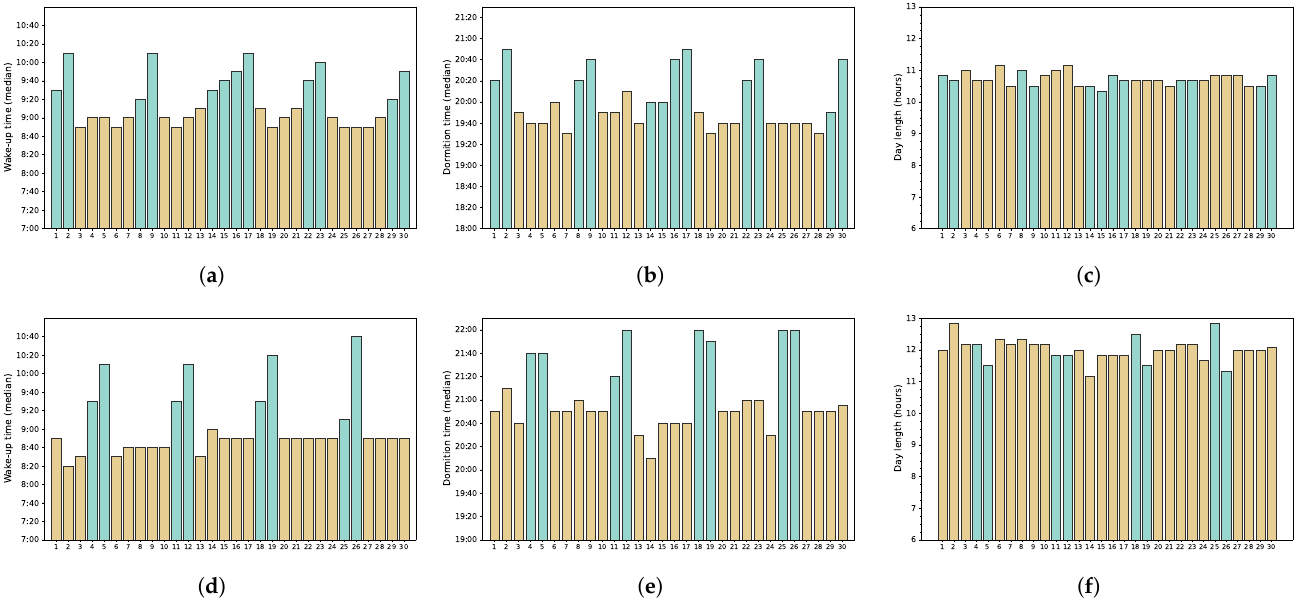
Figure 9. Daily wake-up times ( a , d ), bedtimes ( b , e ), and the day lengths ( c , f ), for the “April 2017” ( a – c ) and the “June 2016” ( d – f ) datasets. Holidays are represented by a different color.